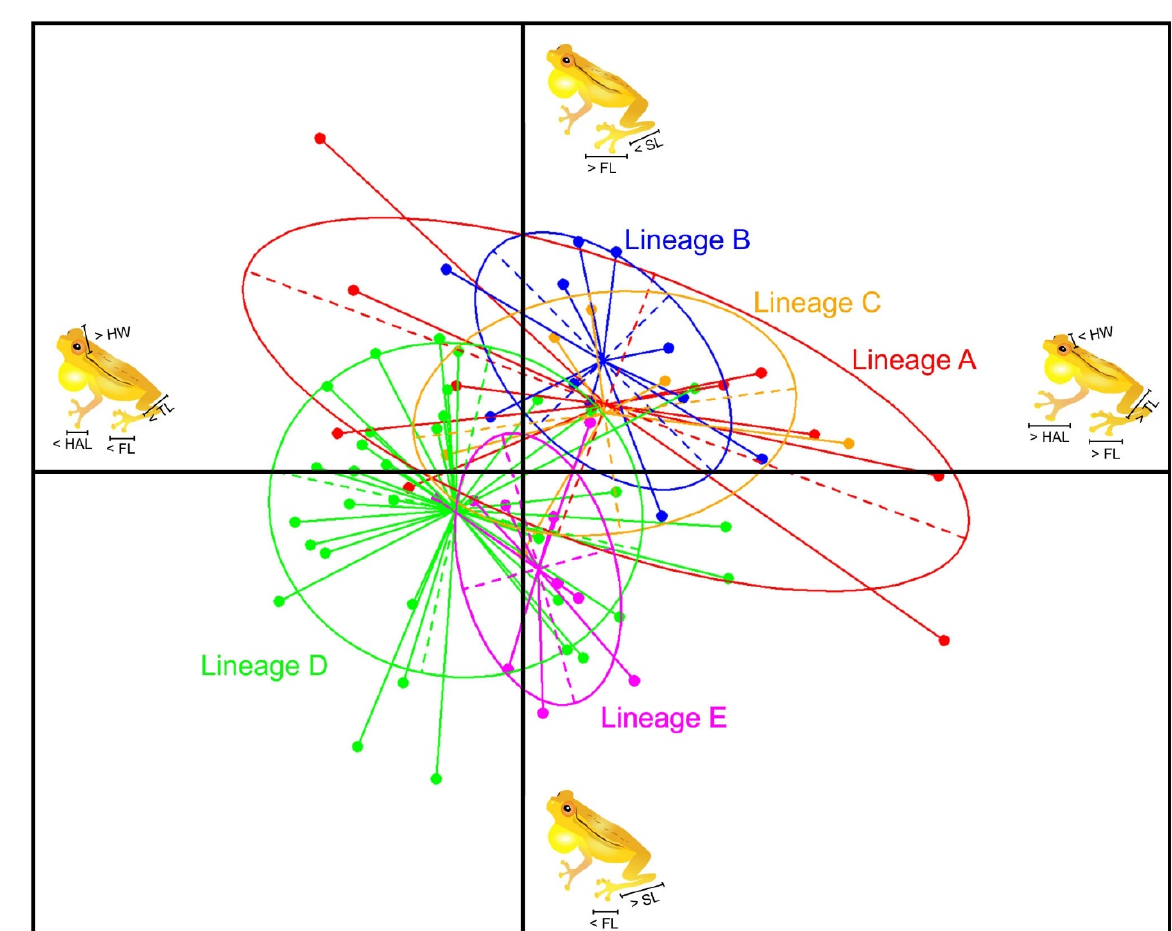
Figure 6. PCA of morphometric ratios. PCA scatter diagrams of nine morphometric ratios obtained from 71 individuals of the 5 lineages recognized in the DNA-based analyses. Each color represents a lineage: red = Lineage A, blue = Lineage B, brown = Lineage C, green = Lineage D and pink = Lineage E. Table 4. Loadings of nine morphometric ratios on the first two principal components (PC1 and PC2) generated by a principal component analysis based on 71 individuals assigned to Lineages A–E. SVL: snout–vent length. HL: head length. HW: head width. TD: tympanum diameter. ED: eye diameter. SL: shank length (= tibia length). FL: foot length. TL: thigh length. HAL: hand length.